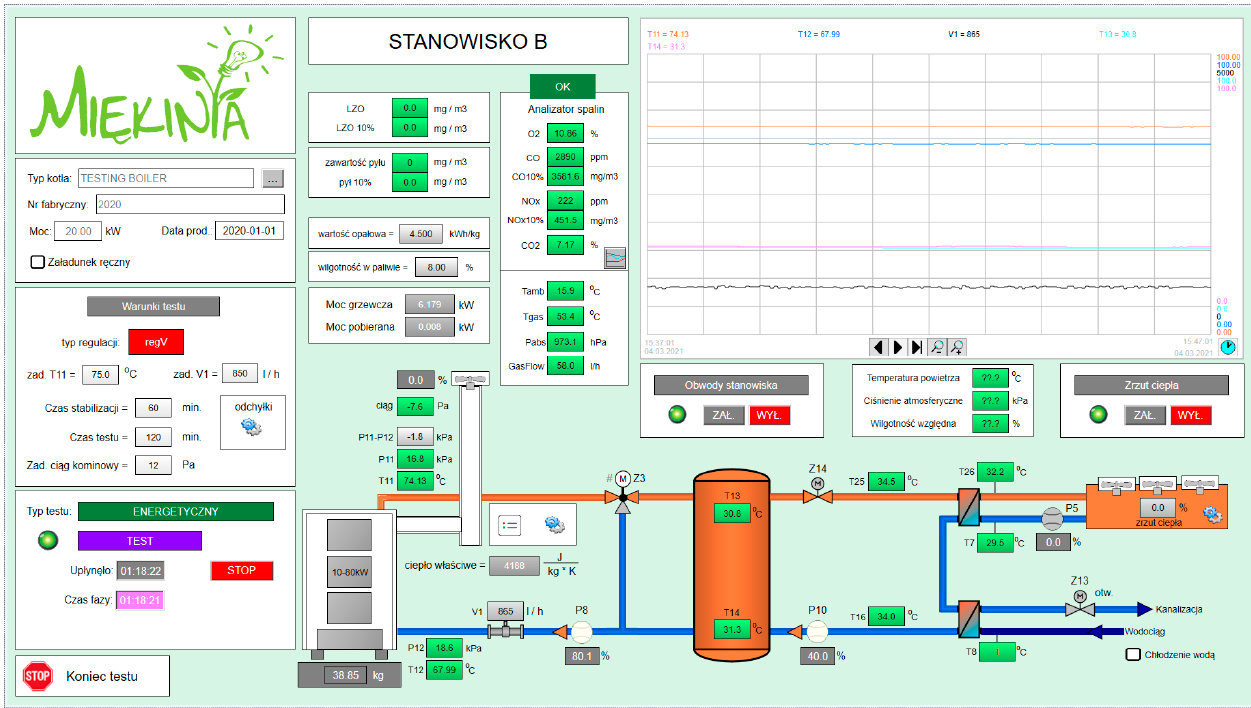
Figure 4. Control panel for the testing system.